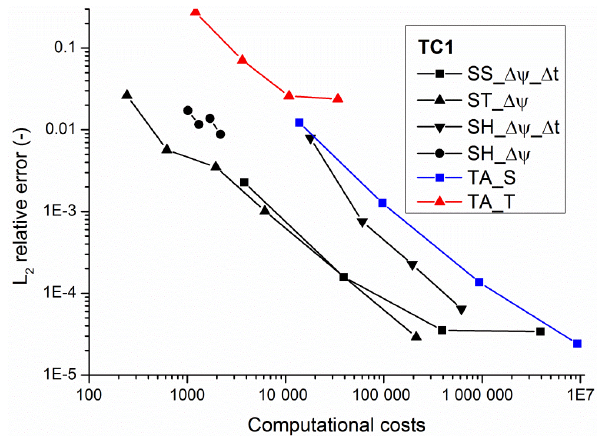
Figure 4. Evolution of the L 2 relative error with computational costs for